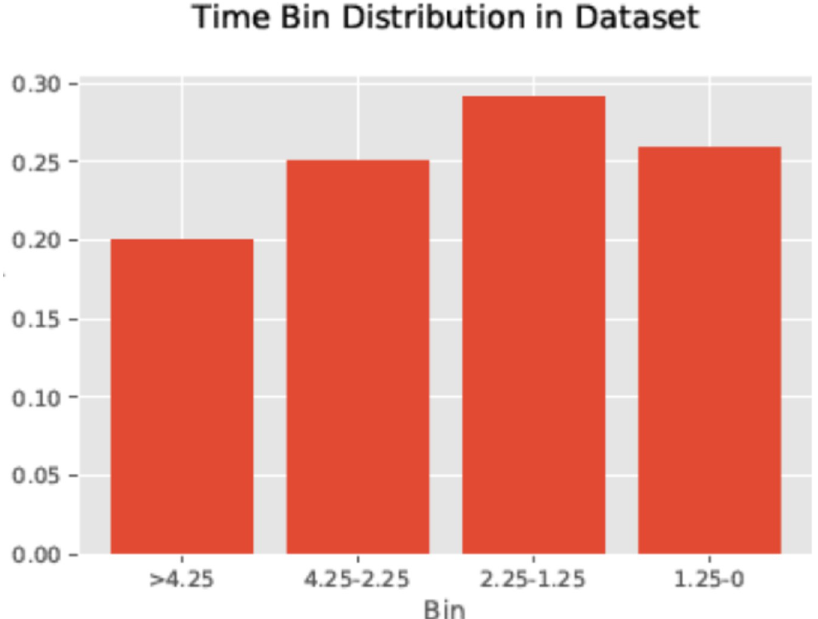
Fig 1. Distribution of subject assessment by time bins. Shows the distribution of elapsed times (by bins) at the point of subject transitioning, having data exported, or having main binary determined. The bar graph displays the proportion of subjects whose status was determined during 4 specific time intervals: prior to 1.25 yrs, 1.25 to 2.25 yrs, 2.25 to 4.25 yrs, and beyond 4.25 yrs. Note that target value ‘1’ subjects included those who transitioned after 2.25 years, or were declared stable at least once at or after that same